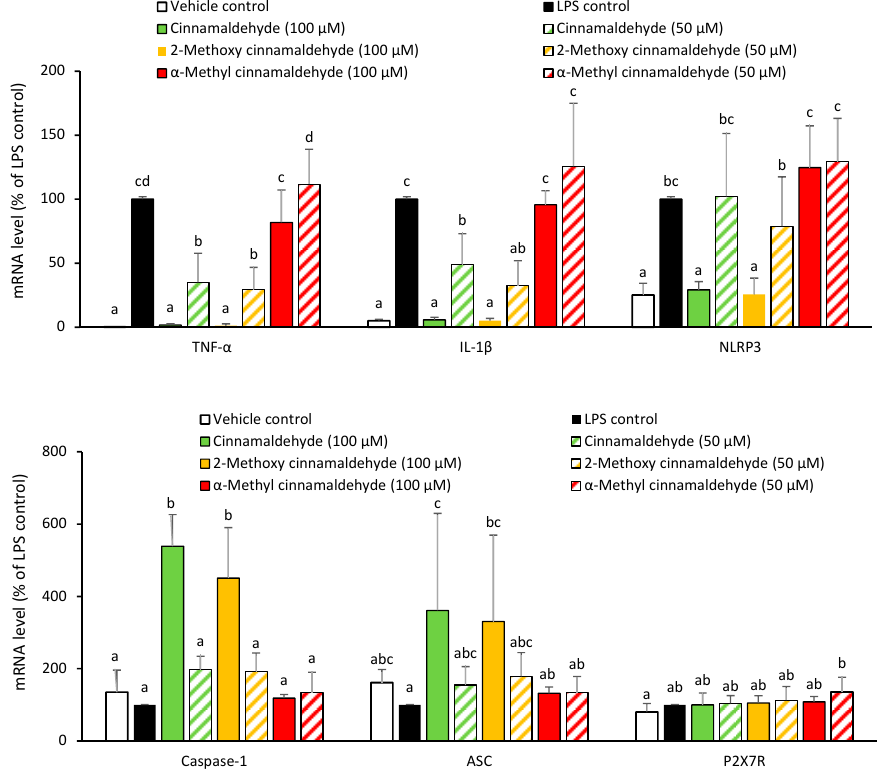
Figure 4. Influence of cinnamaldehyde-related compounds on LPS-primed TNF- α , IL-1 β , NOD-like receptor protein 3 (NLRP3), caspase-1, adaptor proteins- apoptosis-associated speck-like containing CARD (ASC) and P2X7 receptor (P2X7R) mRNA expressions. The macrophages were pretreated with 100 µ M cinnamaldehyde-related compounds for 30 min and then treated with LPS. The mRNA levels were detected by RT-qPCR. Data are expressed as the mean ± SD and different superscript letters represent statistically differences ( p <